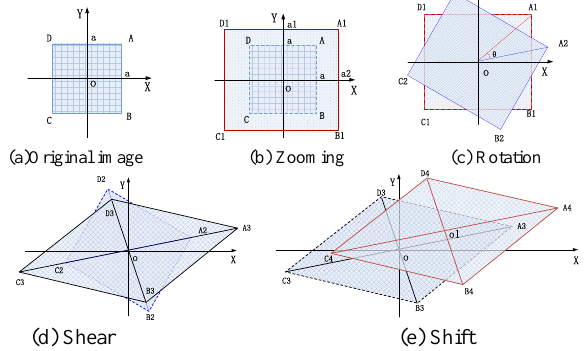
Figure 2.Sketch map of the affine transformation procedure In Figure 2, the dashed line indicates the graph before the transformation; the real line indicates the graph after the transformation. The horizontal scale, the vertical scale, the rotation angle, the shear scale, the horizontal shift, the vertical shift, are named as , , , r d  ,s ,d respectively. Then x y x parameters of formula (5) can be computed with formula (6).